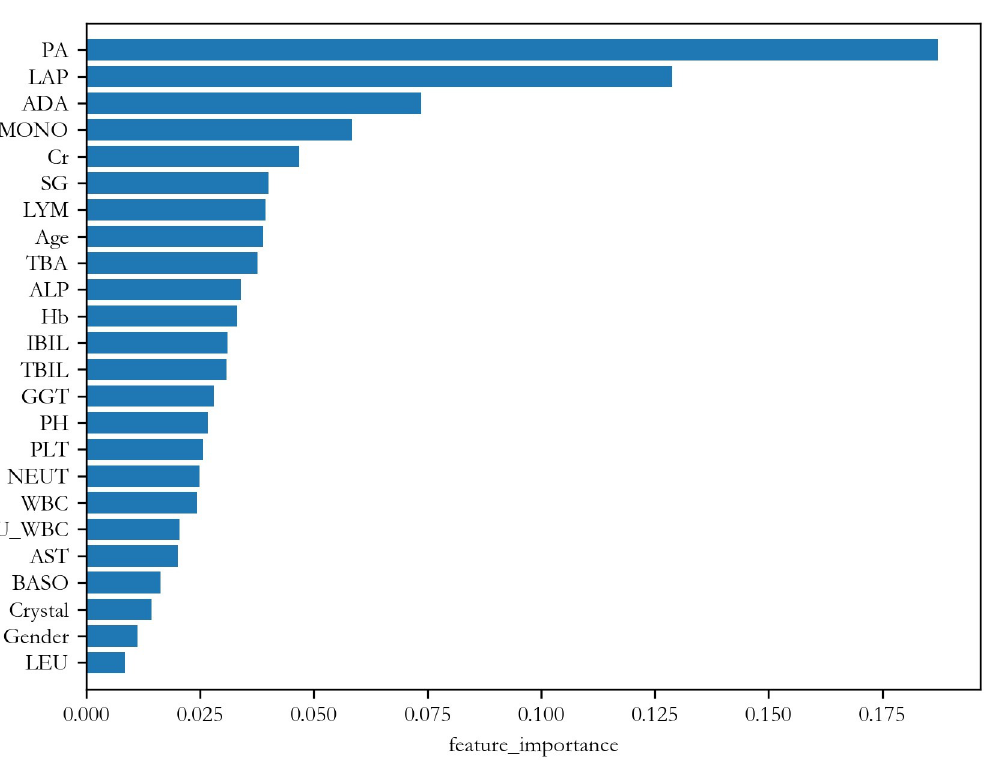
Fig 5. Feature importance ranking when classifying NPC vs. CRS.